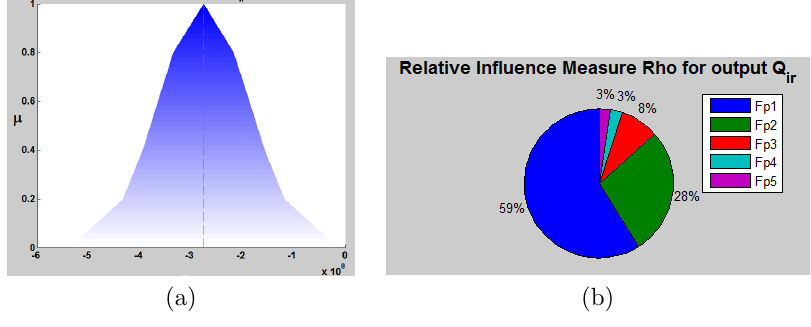
Figure 8. Results for the furnace system: (a) fuzzy output Q ir of furnace system, (b) relative influence measure ρ i for output Q ir